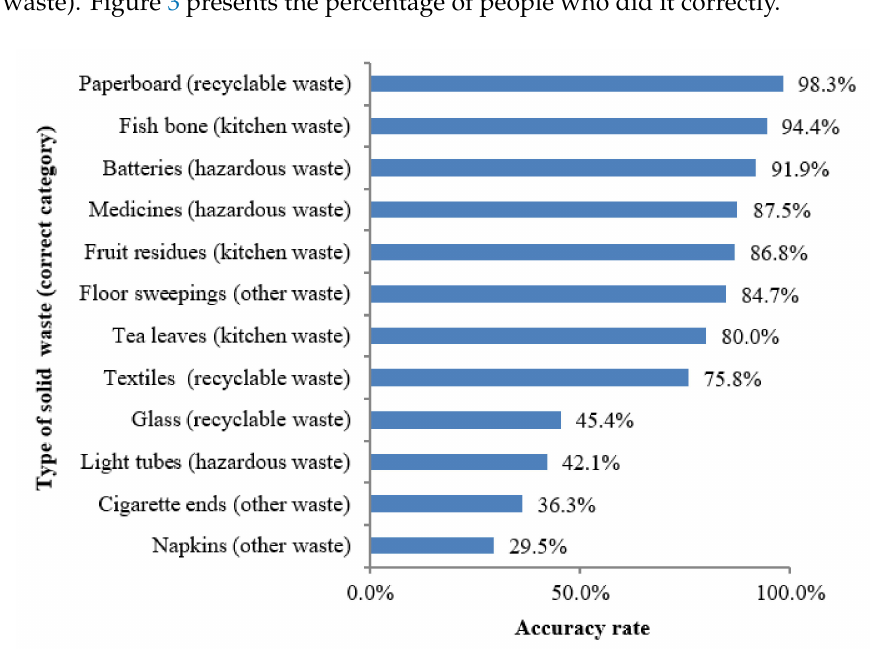
Figure 3. The accuracy rate of waste